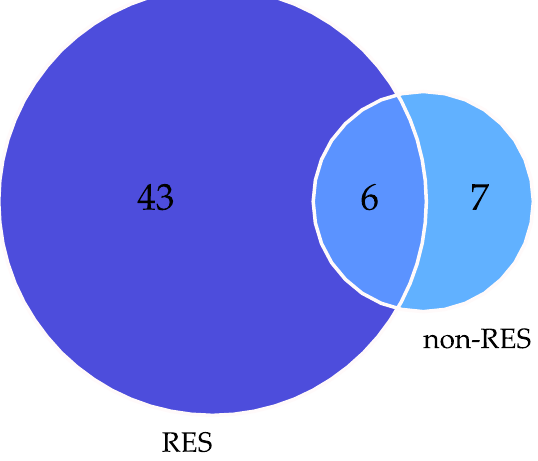
Figure 12. Number of projects per electricity source.